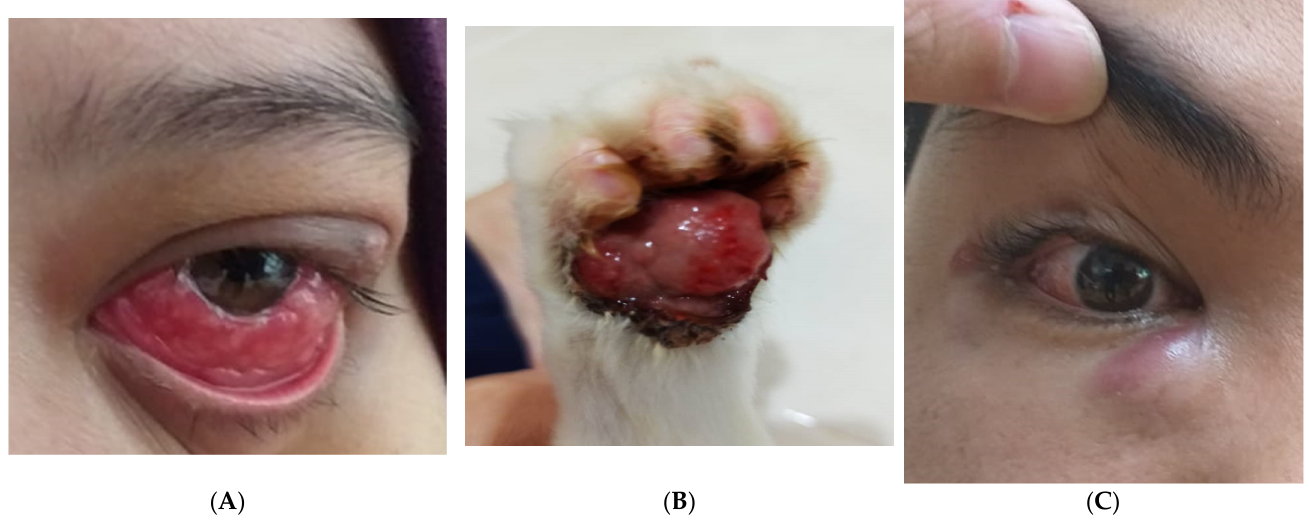
Figure 1. ( A ). Case 1-Granulomatous conjunctivitis of the left eye. ( B ). Infected paw—pet of Patient 1. ( C ). Case 3—Granulomatous conjunctivitis of the right eye with a small granuloma near the